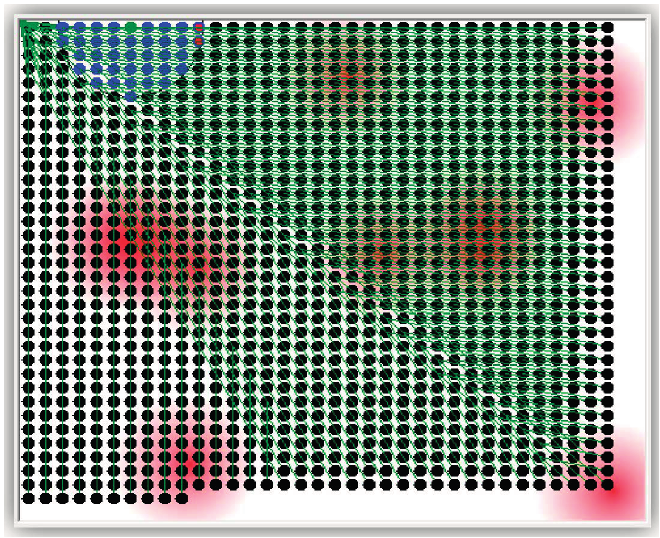
Figure 7. Grid deployment of 1200